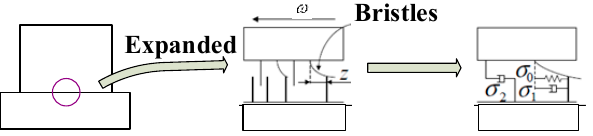
Figure 3. The schematic of the LuGre